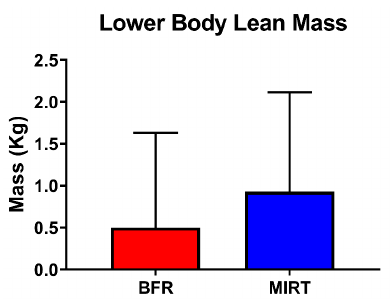
Figure 4. Total lower body lean mass was evaluated from baseline to week 12 via reported the group mean difference. Values indicate estimated marginal mean ± SEM. Abbreviations: BFR—blood-flow restriction; MIRT—moderate-intensity resistance training.